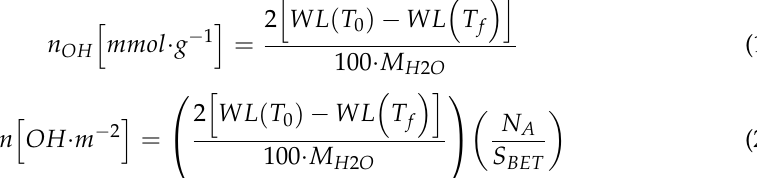
Figure 2. Thermal properties: TGA ( A ) and DTA ( B ) of the investigated samples.